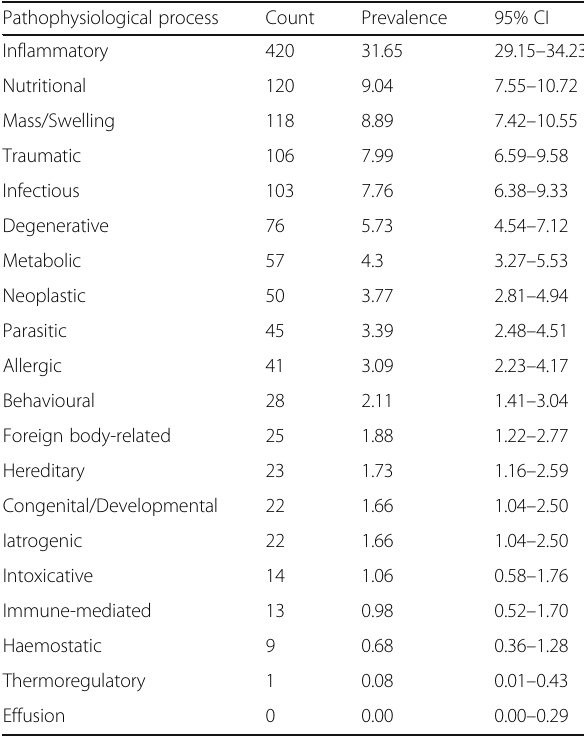
Table 6 Prevalence of pathophysiological processes affected by at least one disorder recorded in Border Terriers attending primary-care veterinary practices in England from January 1st, 2013 to December 31st, 2013 ( n =